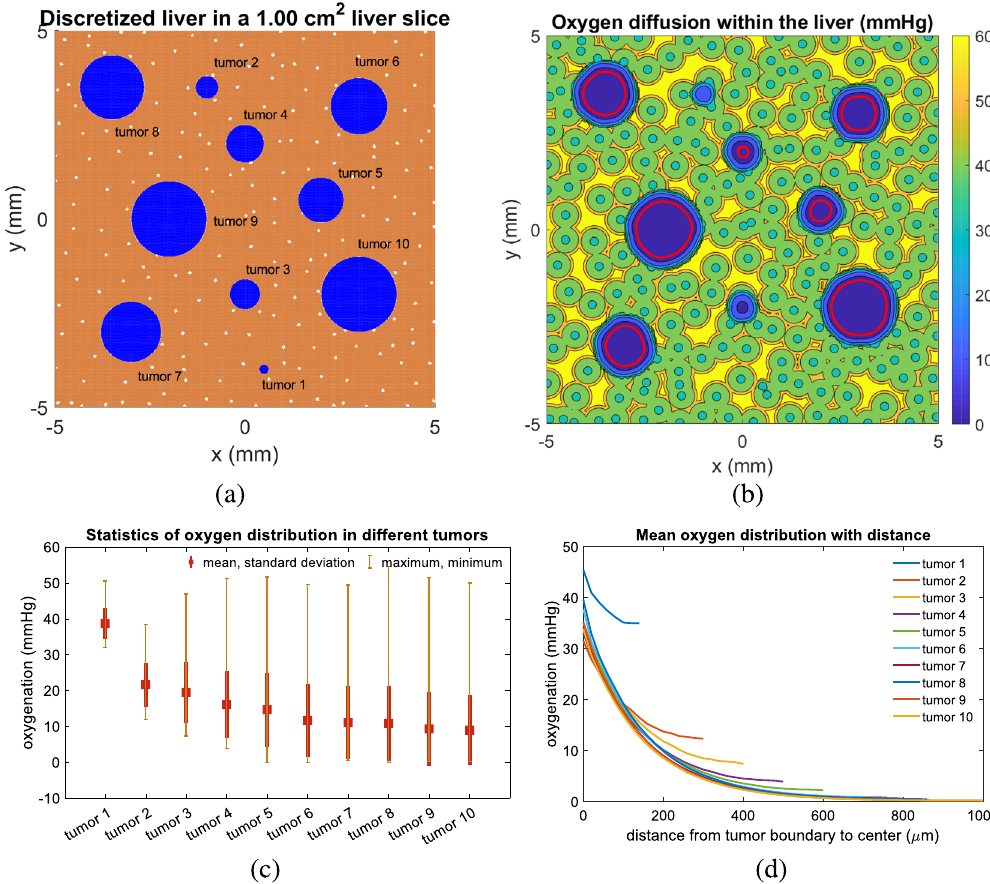
Figure 4. Oxygen distribution inside of 10 tumors (red line is the necrosis threshold value (5 mmHg)) within liver tissue. ( a ) the 10 tumors in liver tissue; ( b ) corresponding oxygen map; ( c ) statistics of oxygen distribution in the different tumors; ( d ) corresponding mean oxygen distribution with